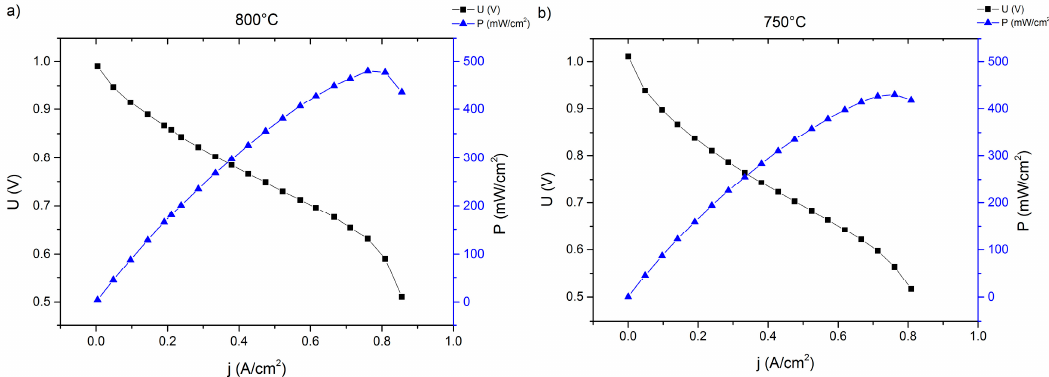
Figure 3. I-V- and I-P-curves of cell 1 of the lightweight MSC stack after joining, measured at 800 °C ( a ) and 750 °C ( b ).